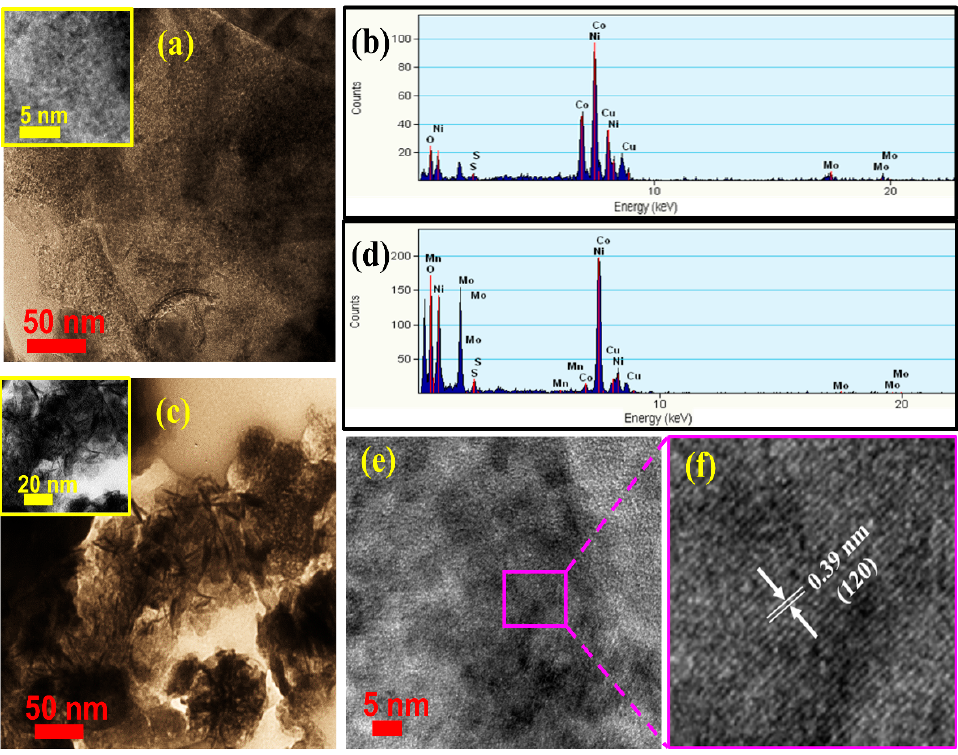
Figure 4. ( a ) TEM image (inset — high-magnification image) and ( b ) the corresponding EDX spectrum of NCMS; ( c ) TEM image (inset: high-magnification image) and ( d ) the corresponding EDX spectrum of NCMSM; ( e , f ) HRTEM image of NCMSM showing the lattice fringes of (120) planes. The chemical composition of NCMS and NCMSM was investigated by XPS